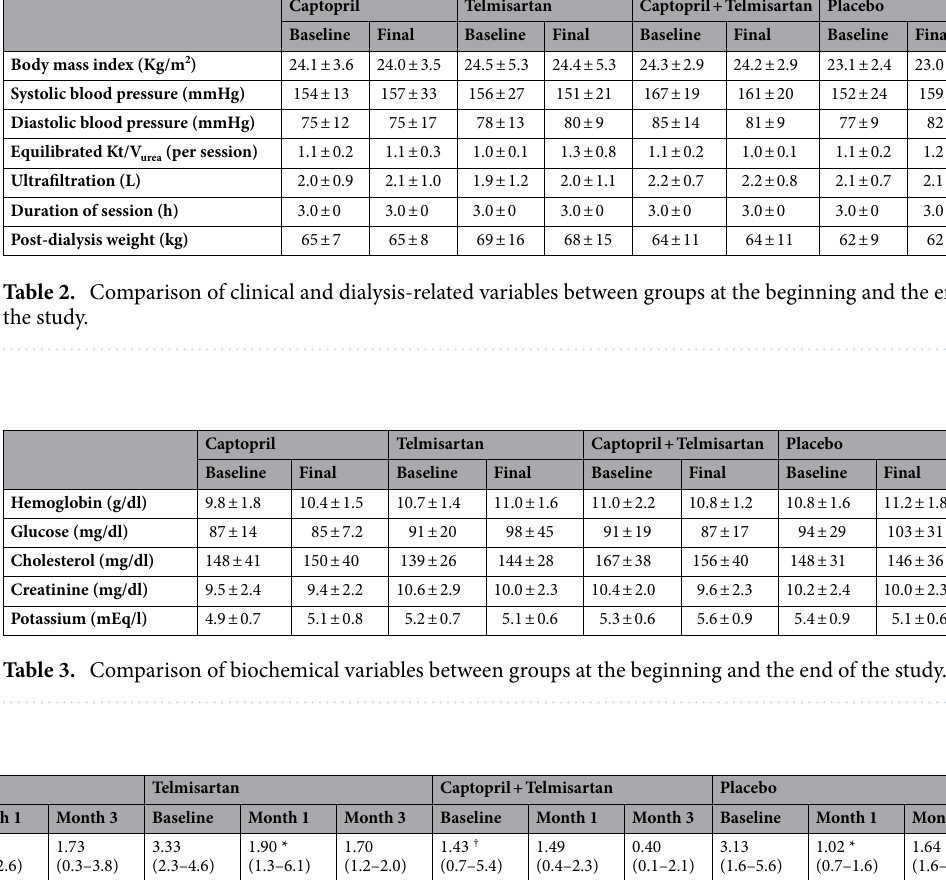
Table 4. Comparison of inflammation markers between groups at baseline, month 1 and month 3. † p < 0.05 versus Telmisartan in the same evaluation; * p < 0.05 versus baseline evaluation in the same group; £ p < 0.05 versus Captopril + Telmisartan in the same